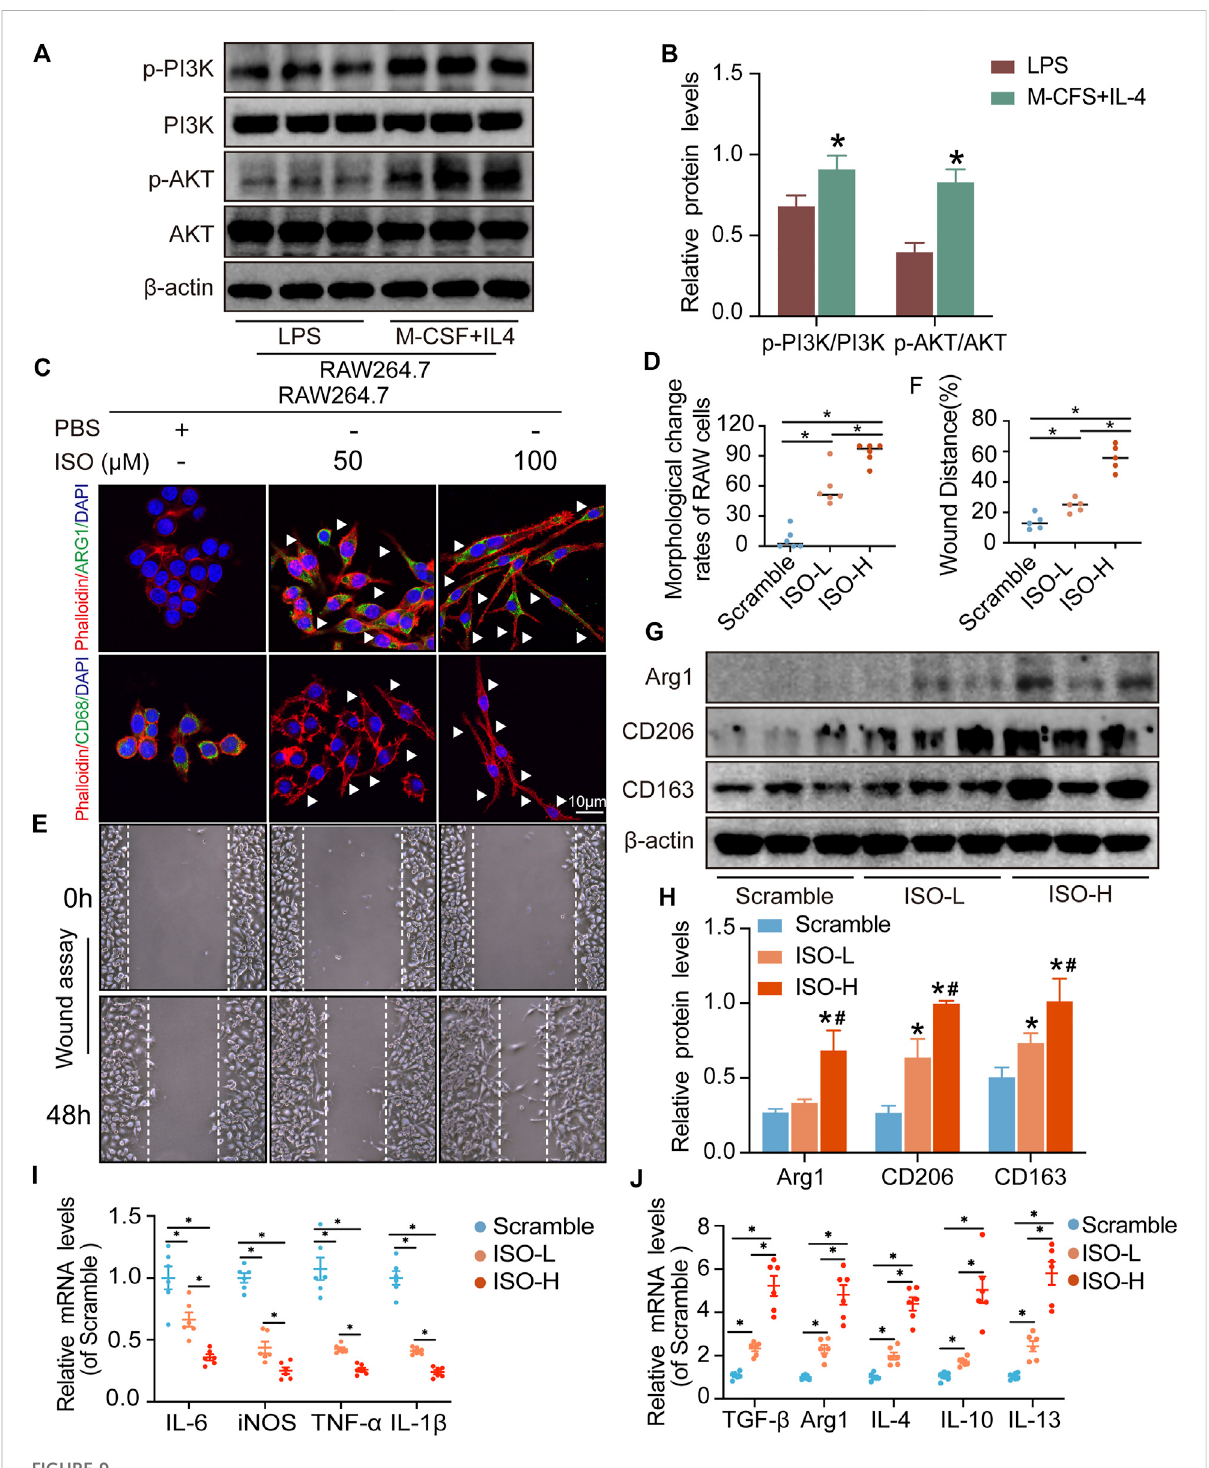
FIGURE 9 ISO promoted M2 polarization of macrophages in vitro . (A,B) Expressions of PI3K, p -PI3K, AKT, and p -AKT proteins were tested in RAW264.7cells( n =3,* p < 0.05,comparedwiththeLPSgroup). (C,D) Visualizationandquantitativeanalysisofco-locationofphalloidinandCD68or Arg1ofRAW264.7cellsindifferentgroups( n =6,* p < 0.05). (E,F) VisualizationandquantitativeanalysisofwoundassayofRAW264.7cellsindifferent groups ( n = 6, * p < 0.05). (G,H) Expressions of ARG1, CD206, and CD163 proteins were tested on RAW264.7 cells in different groups. (I) mRNA expression of M1 macrophage markers ( n = 3, * p < 0.05). (J) mRNA expression of M2 macrophage markers ( n = 6, * p <